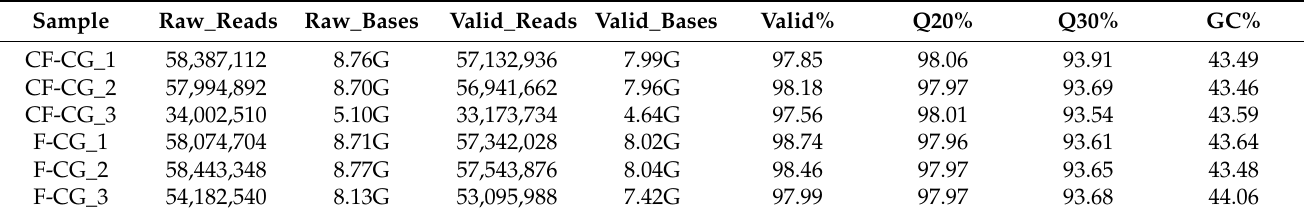
Table 1. The RNA-seq data for these 6 samples.